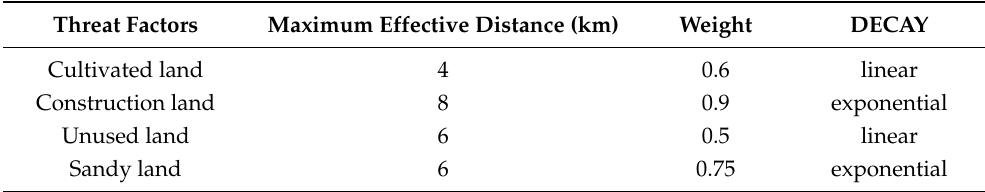
Table 2. Maximum influence distance and weight of threat factors.